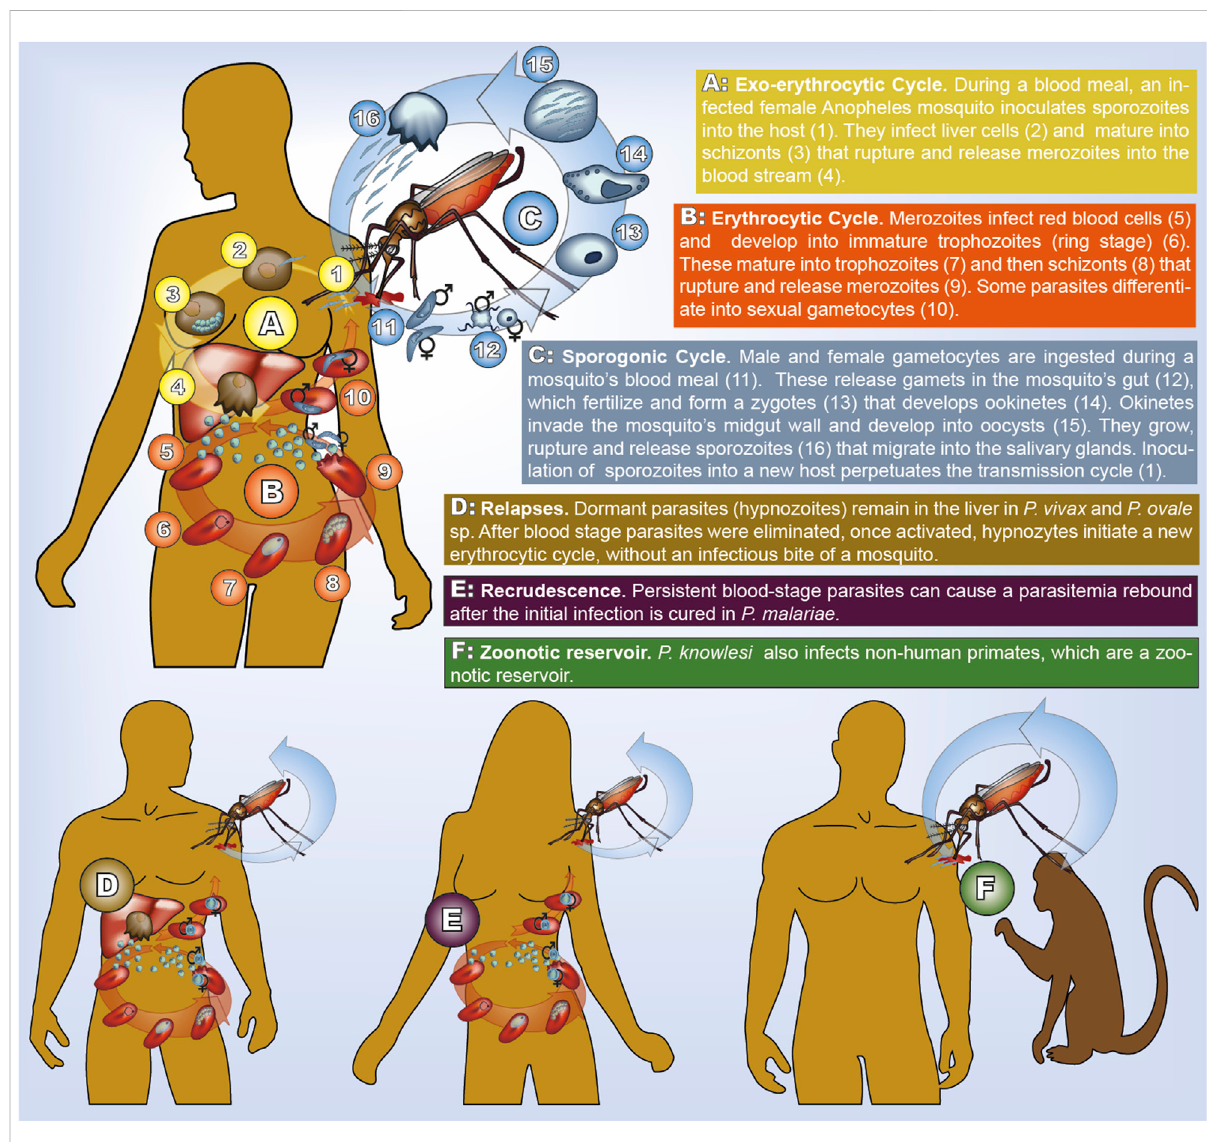
Transmissioncycleofhumanmalaria.Allspecieshavethesamecycle,butparasiteslife-stageshavedifferentmorphology(illustratedherefor P. falciparum ). In P. vivax and P. ovale sp. dormant hypnozoites remain in the liver. In P. malariae recrudescence form prolonged blood stage parasites occur. In P. knowlesi humans and non-human primates can be